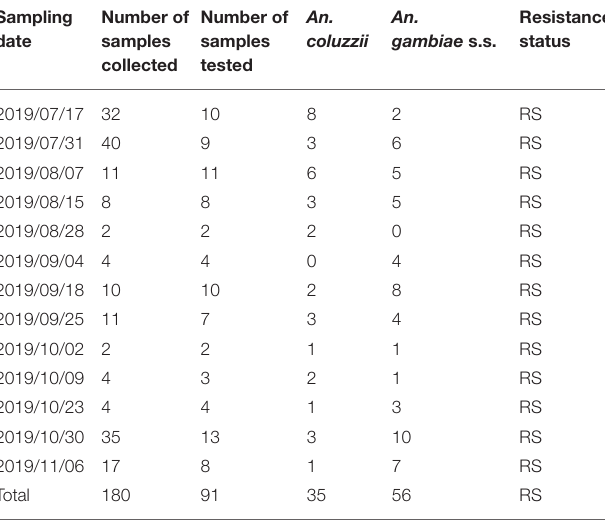
TABLE 4 | Molecular identification of members of the An. gambiae complex collected in the Lakka surveillance site.